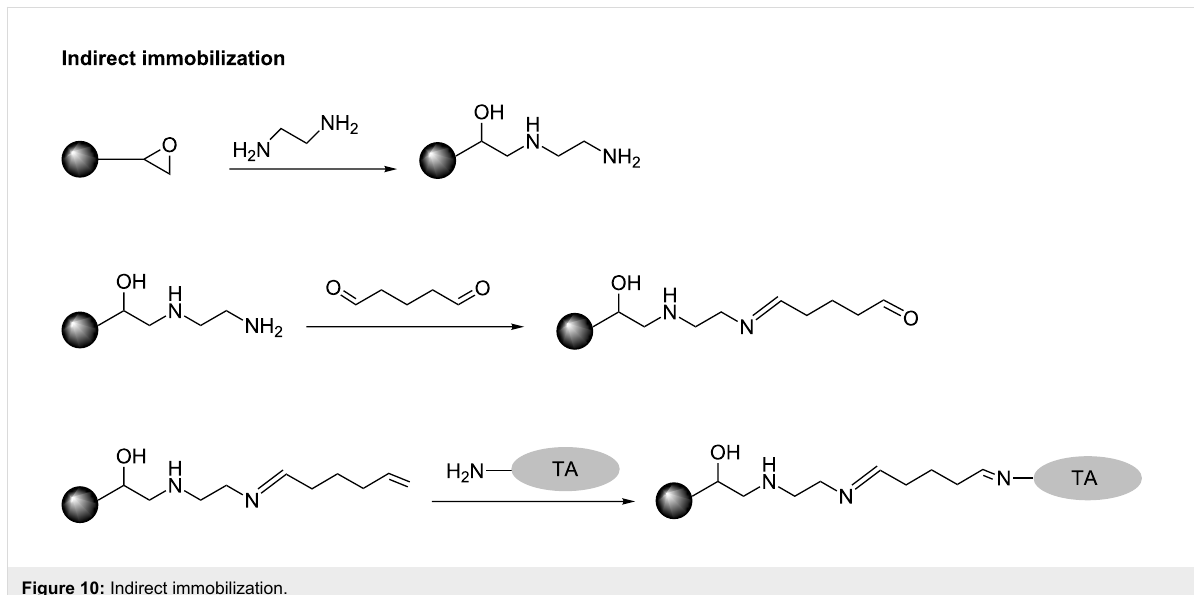
Figure 10: Indirect immobilization.